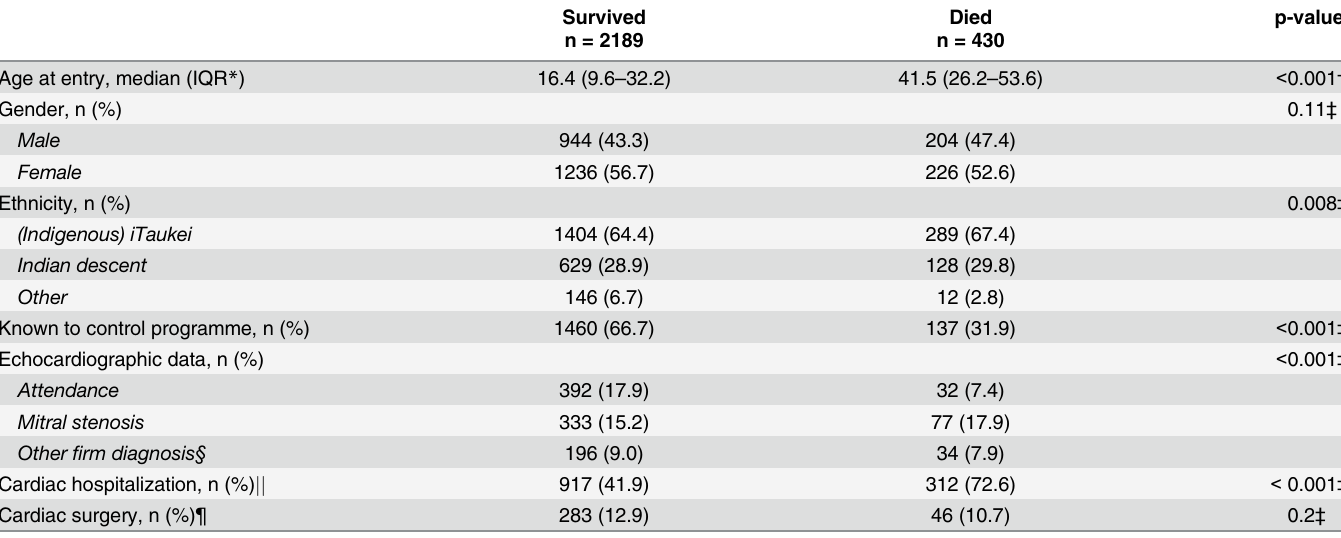
Table 1. Characteristics of the cohort by